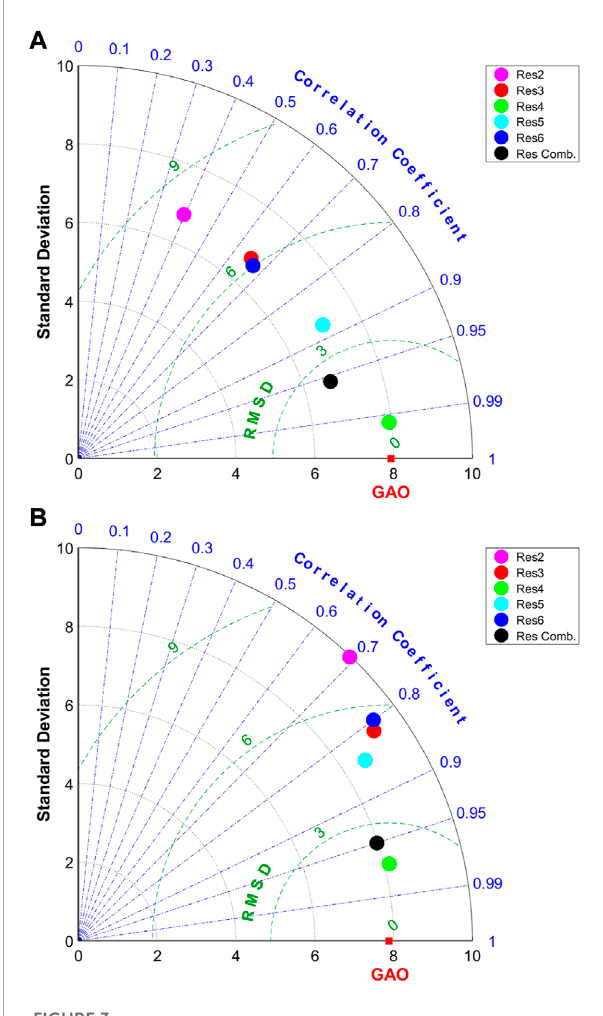
FIGURE 3 Taylor Diagrams showing a comparison of χ 1 (upper panel (A) ), and χ 2 (bottom panel (B) ) components of different geodetic residuals (GAO=Res1, as referenced value). The comparison is done for time series presented in Figure 2